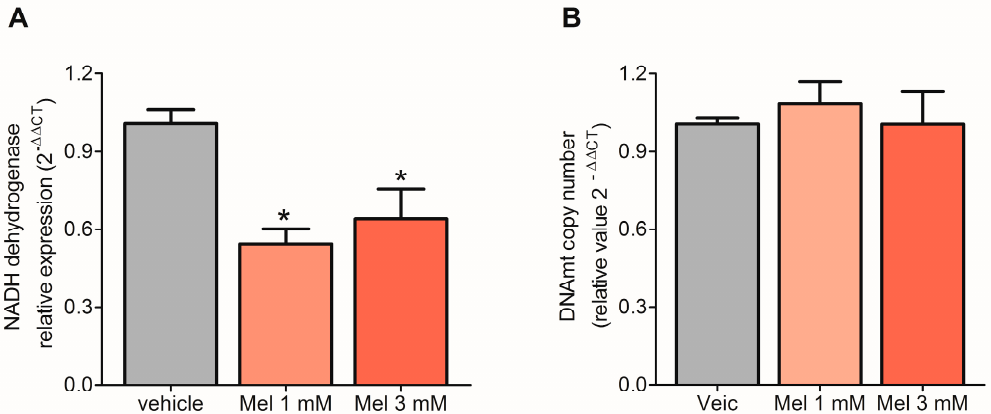
Figure 3. Melatonin inhibits mitochondrial NADH dehydrogenase 1 gene expression but does not affect mitochondrial DNA (mtDNA) replication—Cultured U87MG cells were incubated with melatonin (1 mM or 3 mM) for 72 h, and the medium was exchanged every 24 h. The relative expression of the NADH dehydrogenase 1 gene ( A ) and mtDNA copy number ( B ) were determined by qRT-PCR, using mitochondrial RNA and DNA as a template, respectively. The data are expressed as the relative quantification (2 − ∆∆ Ct ) compared to the vehicle-treated groups (ethanol 0.3% or 0.9%). Gene expression did not differ in cells treated with vehicle or 0.3% and 0.9% ethanol, and these groups were represented as a single bar * p < 0.05, tested with an analysis of variance followed by the Bonferroni post-hoc correction using GraphPad Prism ® version 5, comparing the effect of melatonin to the vehicle group.